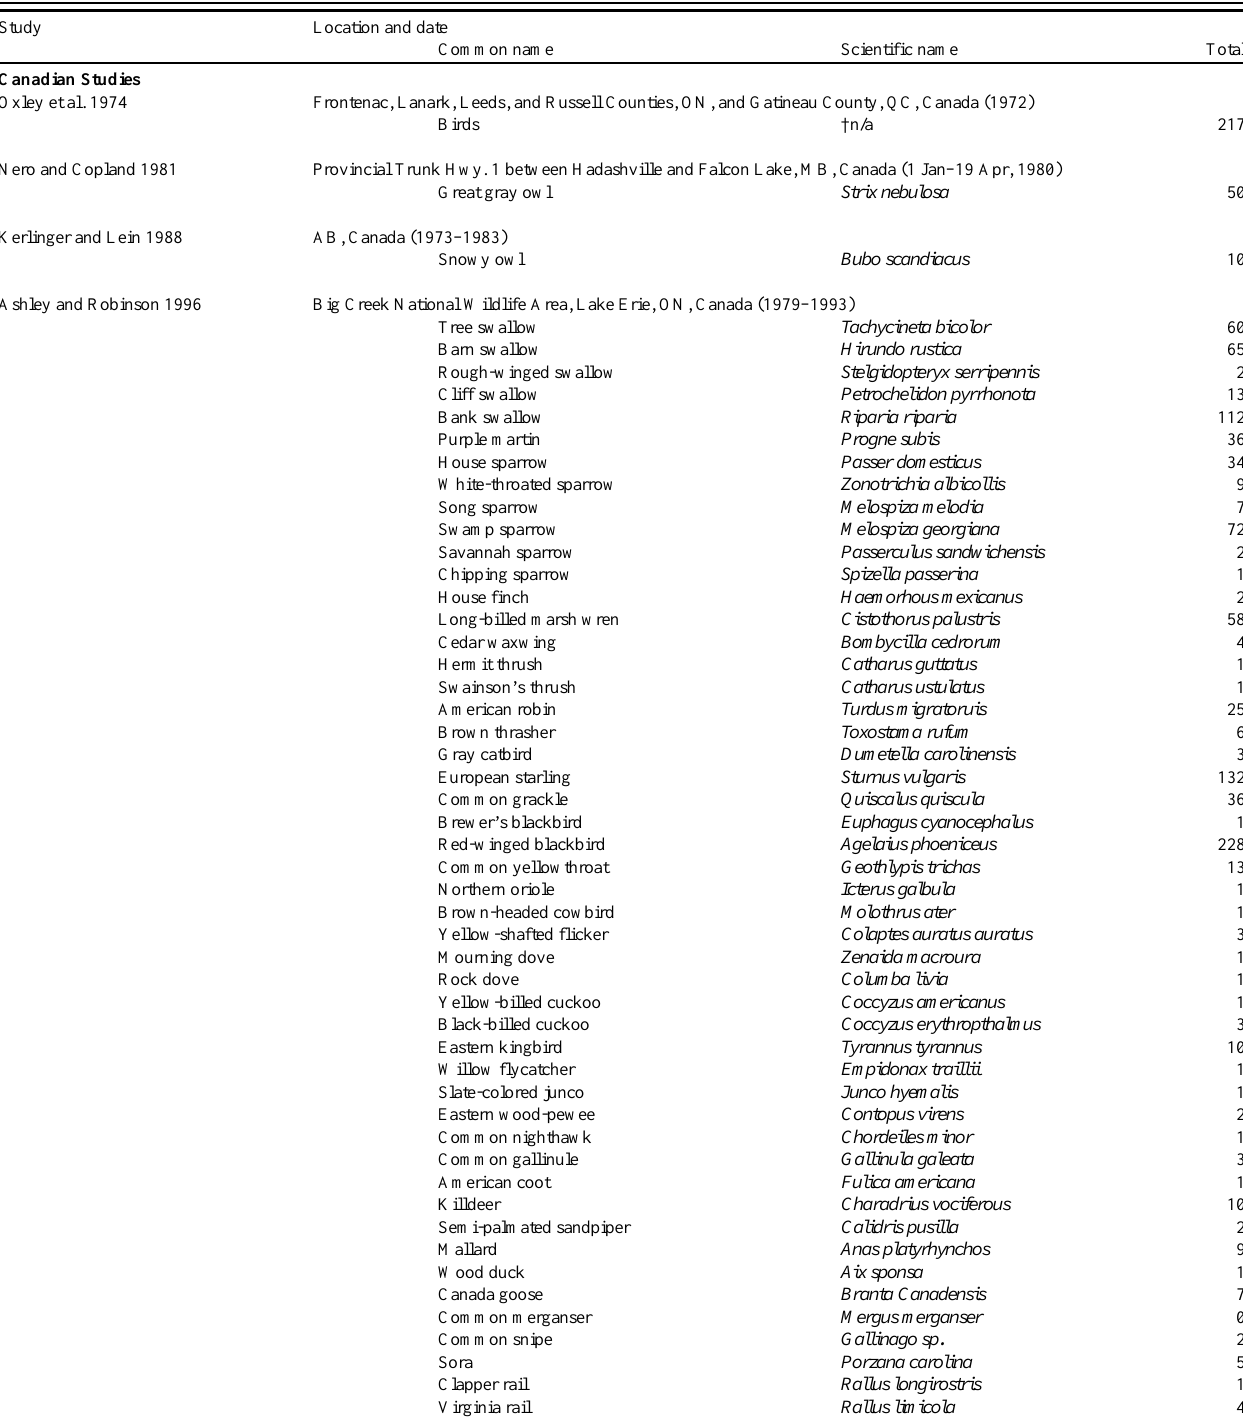
Table 1 . Results of surveys of roads for avian casualties attributed to collisions with vehicles in North